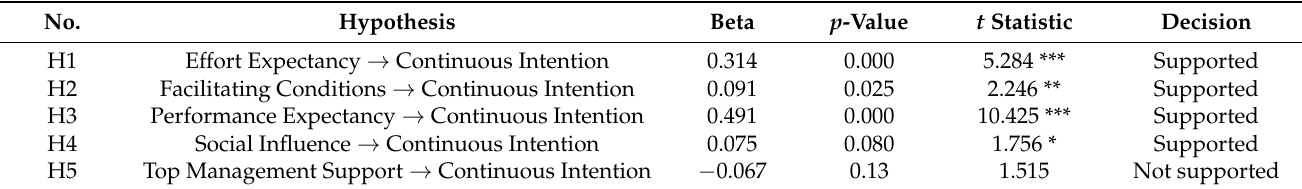
Table 5. Direct Relationship Hypotheses.